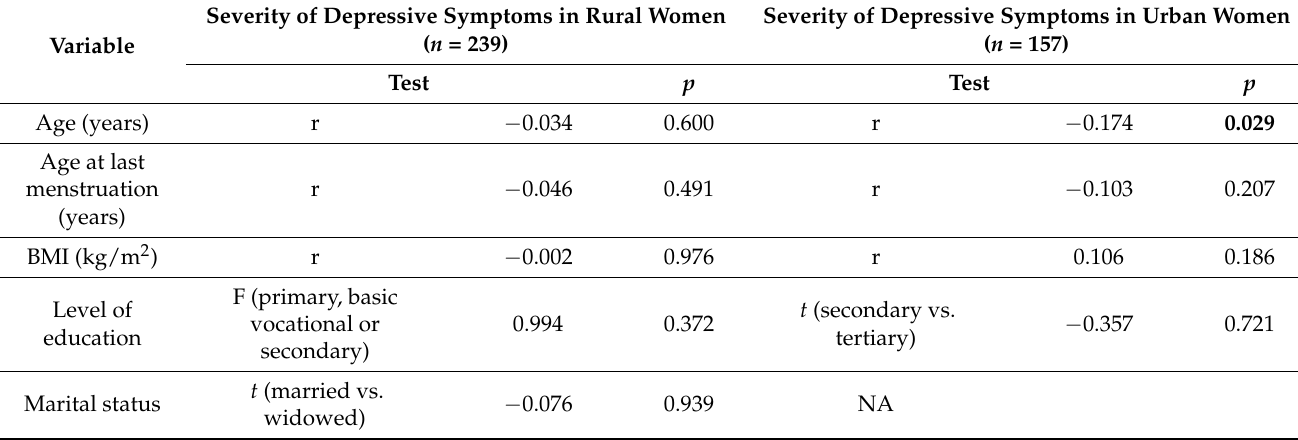
Table 3. Correlations between severity of depressive symptoms and study group characteristics.